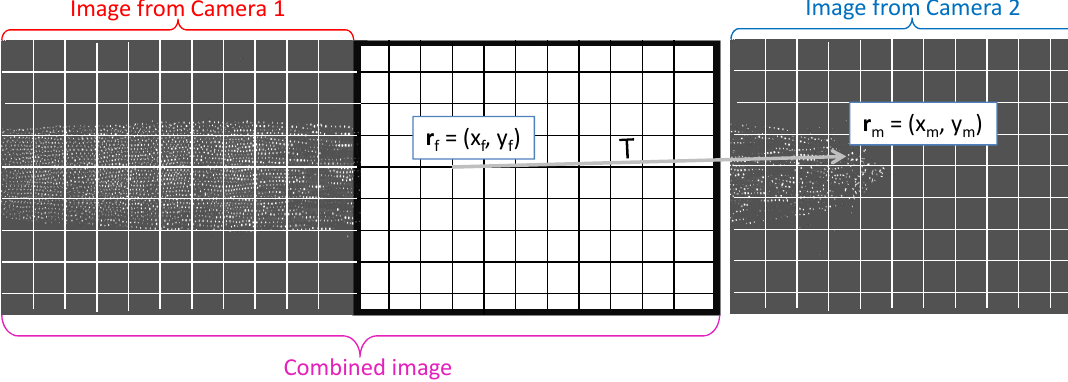
Figure 3. Demonstration of the transformation. We need to fill in the empty pixels of the combined image, shown on the left in this figure. The left part of the combined image is filled by simply copying the image recorded with Camera 1, since the coordinate space for the combined image is that of Camera 1. To fill the right part of the combined image, we need the transformation T that will tell us which is the point r m in the right image (recorded with Camera 2) that goes to a certain position r f in the fixed space of the combined